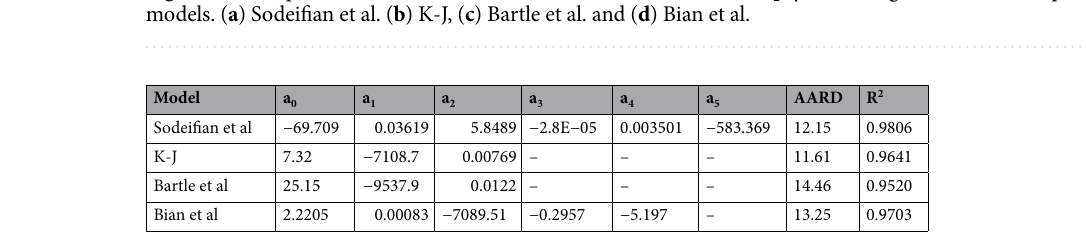
Table 4. Correlation outcomes of Decitabine-SC-CO 2 system obtained by various semi-empirical